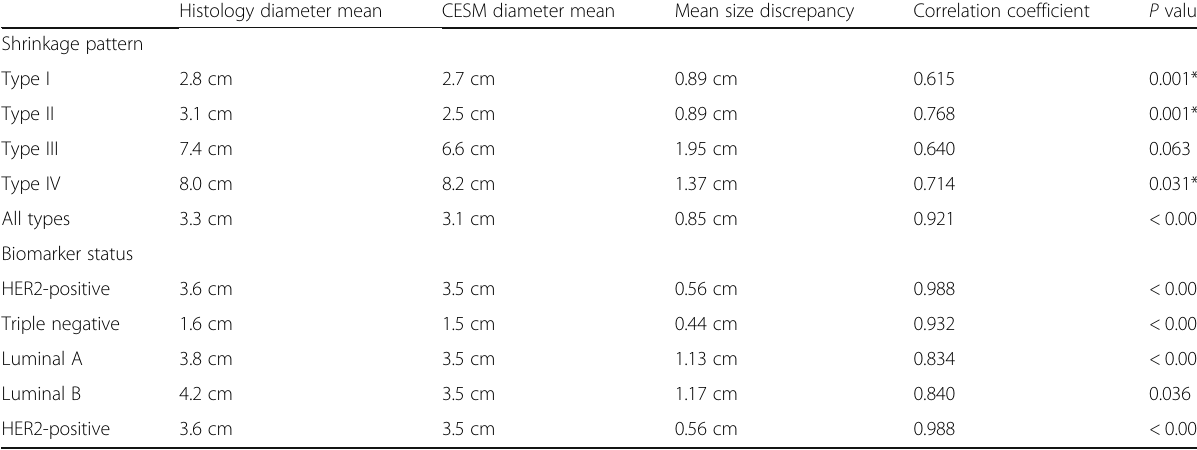
Table 8 Correlation of tumor diameter obtained from CESM with histological tumor diameter according to the shrinkage patterns and biomarker status of the